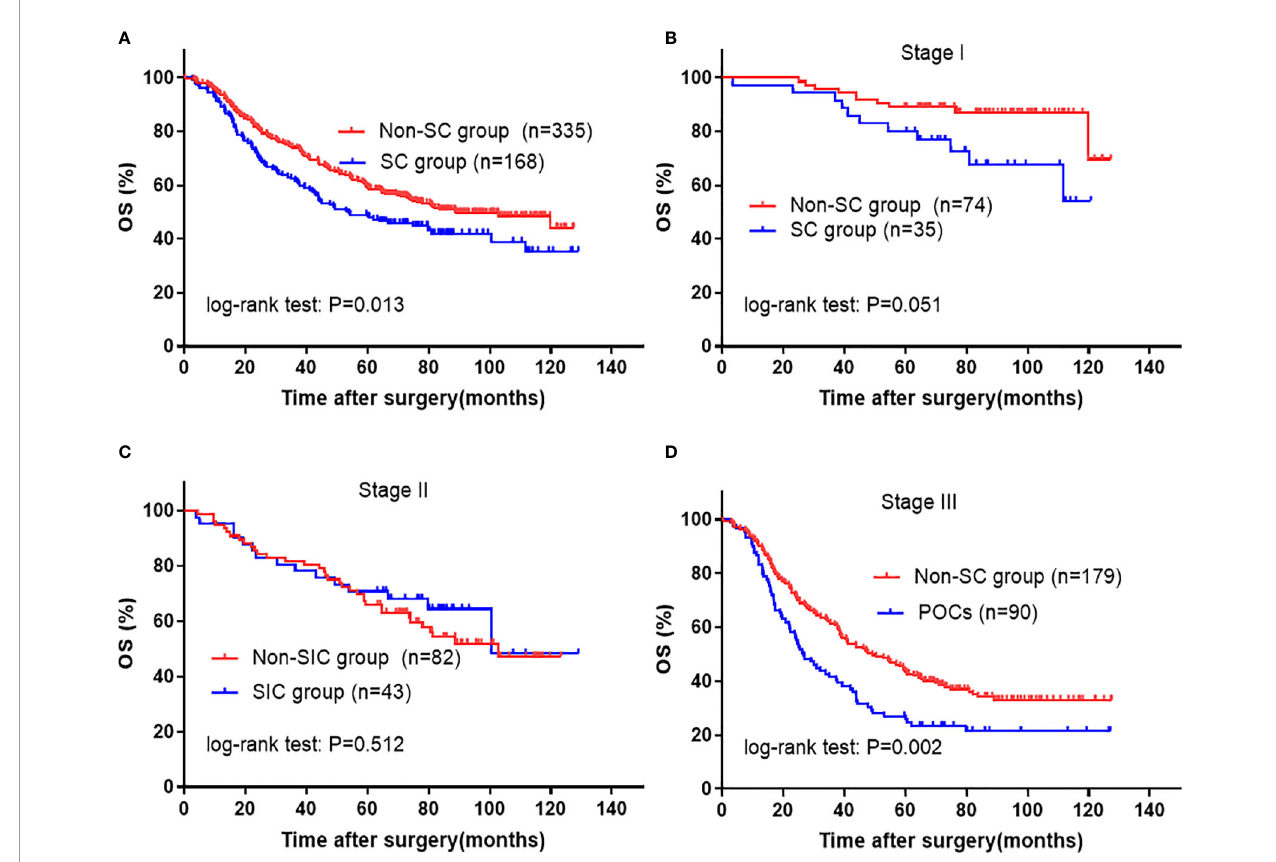
FIGURE 4 | Kaplan-Meier survival analysis of SC in PSM cohort. (A) in all patients; (B) in Stage I, (C) in Stage II, and (D) in Stage III patients. The signi fi cance of the difference between survival curves was calculated by the log-rank test. SC, severe